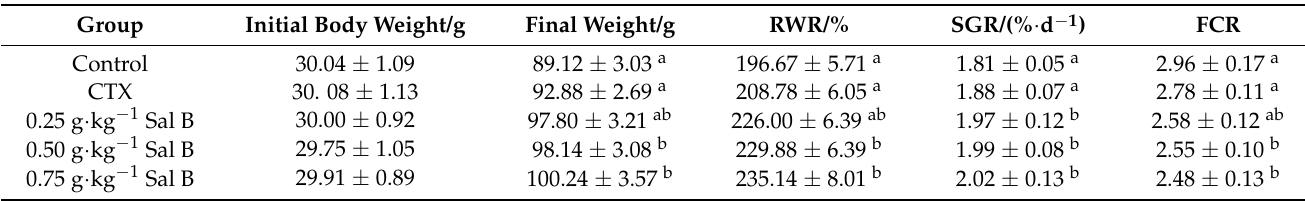
Table 3. Effects of Sal B on growth indexes of Nile